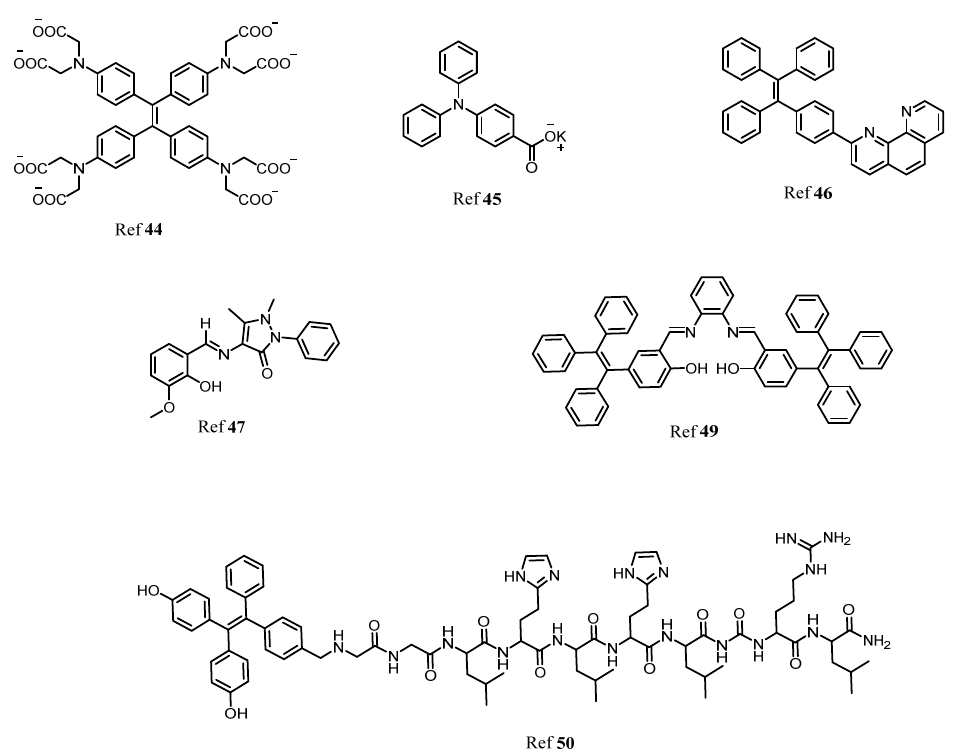
Figure 7. The various AIE active fluorophores illustrated for detection of Zn 2+ ion in solution.